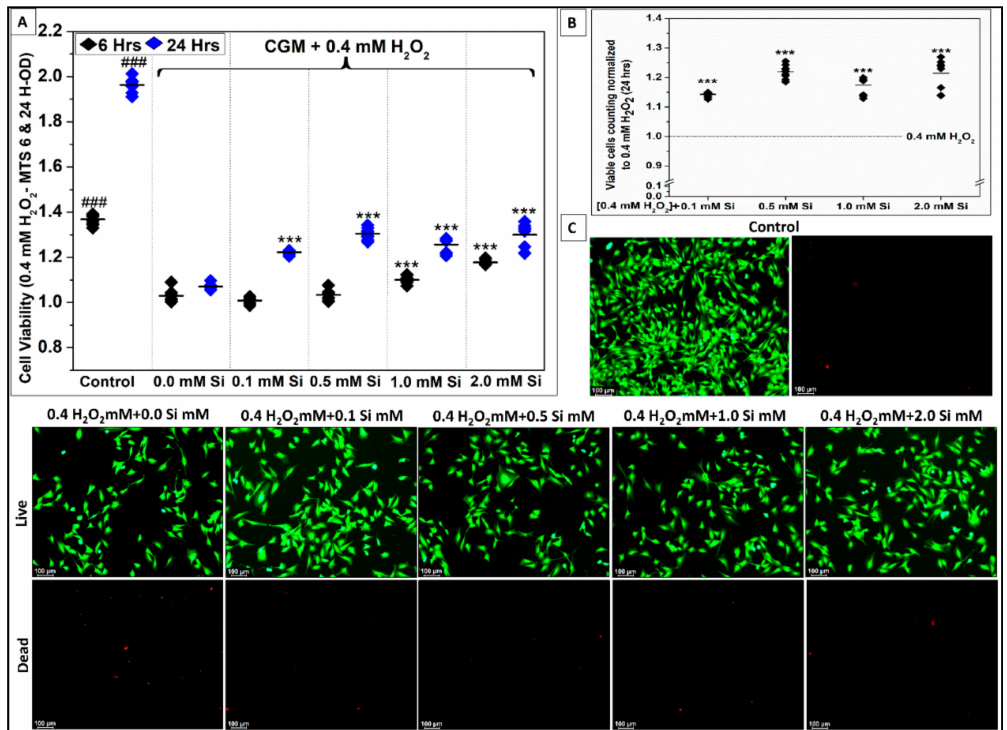
Figure 7. Silicon ions attenuate the effect of toxic oxidative stress (0.4 mM H 2 O 2 ) on C2C12 myoblast cells. ( A ) Data distribution graph presents the cell viability results using MTS assay after 6 and 24 h of C2C12 cell culturing in complete growth media (CGM, Control), supplied with 0.4 mM H 2 O 2 , (test groups) with 0.0, 0.1, 0.5, 1.0 mM Si-ions. 0.0 mM Si indicates that 0.4 mM of H 2 O 2 into the growth media significantly decreases the cell viability after 6 and 24 h compared to the control (*** p < 0.001, n = 4 per group), addition of 0.5–1.0 mM of Si into the growth media under ROS significantly enhances the cell viability compared to 0.4 mM H 2 O 2 without Si ( p < 0.05, n = 4 per group). ( B ) Data distribution graph presents the number of cells normalized to 0.4 mM H 2 O 2 without Si confirming the same results from the MTS-assay. ( C ) Fluorescent pictures (10 × view) of C2C12 cells stained with calcine Am stain showing cells after being exposed to H 2 O 2 for 24 h. ( ___ ) in the graphs represents the mean and the scale bar on the fluorescent pictures is 100 µ m. ### p <